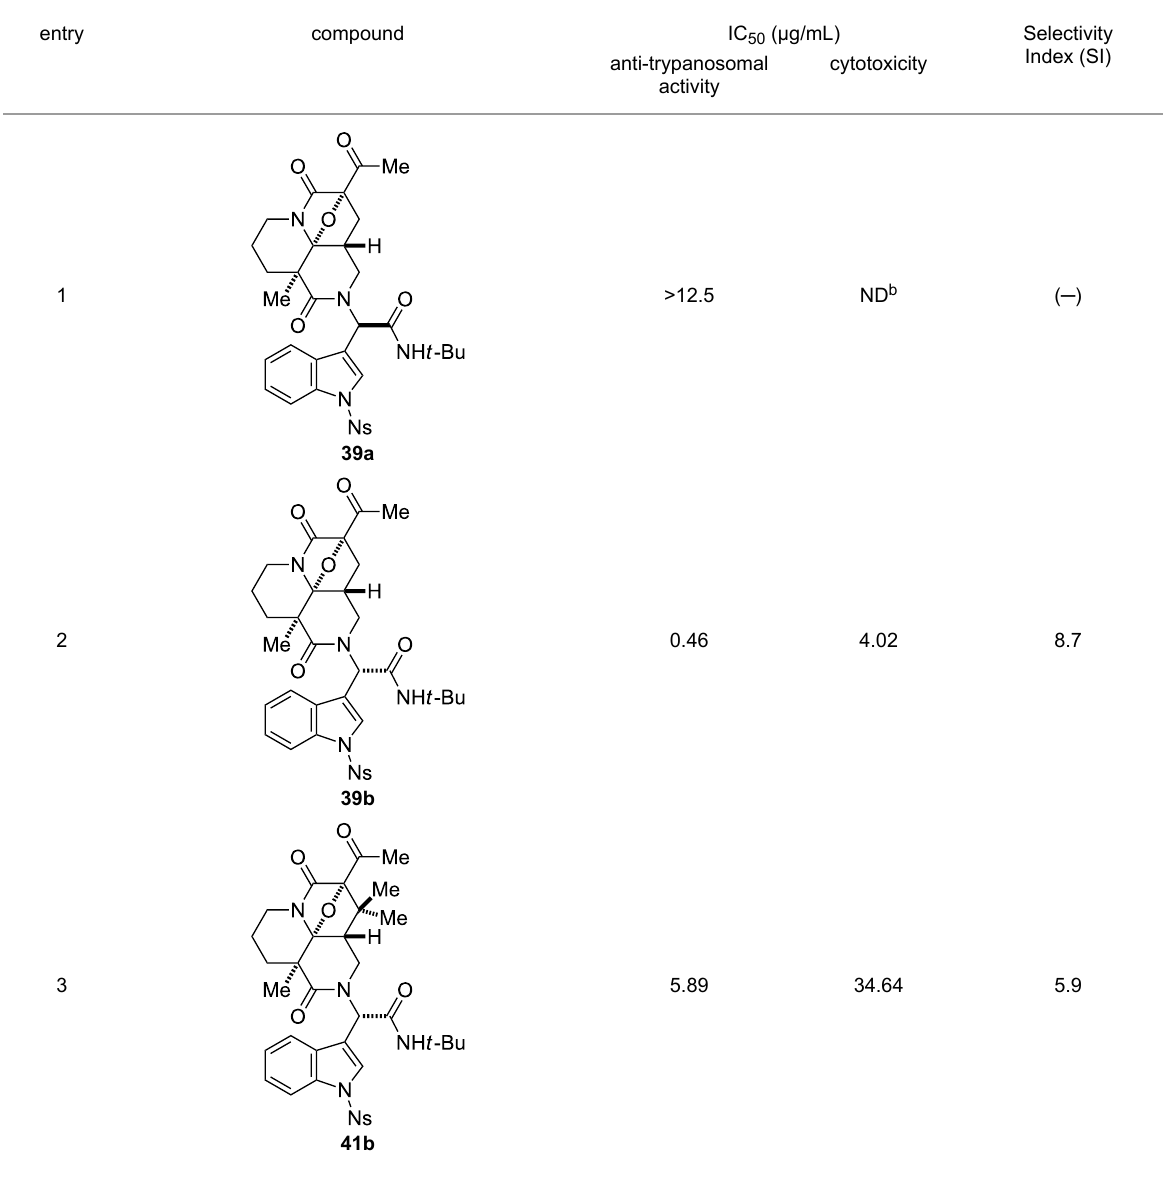
Table 1: In vitro anti-trypanosomal activities of natural product analogues and approved drugs against T. brucei brucei GUTat 3.1 a